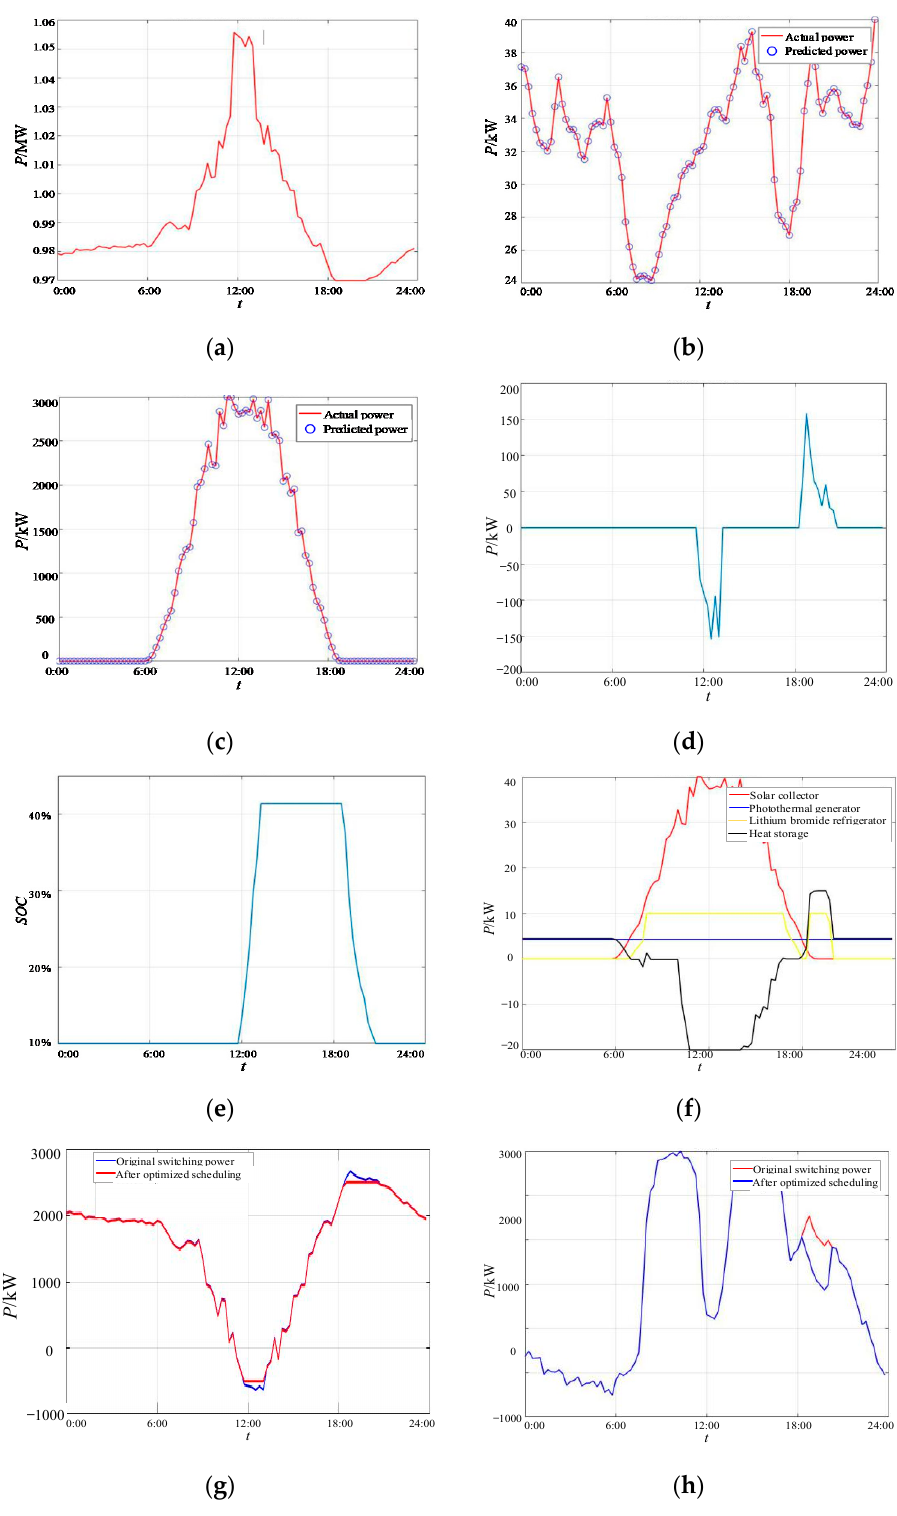
Figure 6. Optimal scheduling results of AC/DC hybrid distribution system. ( a ) Voltage of low-voltage DC side of power electronic transformer. ( b ) Predicted and actual wind power. ( c ) Predicted and actual PV power. ( d ) Charging and discharging power of energy storage. ( e ) SOC of power storage. ( f ) Photothermal system. ( g ) Exchange power between AC/DC hybrid distribution system and AC main network. ( h ) Load.